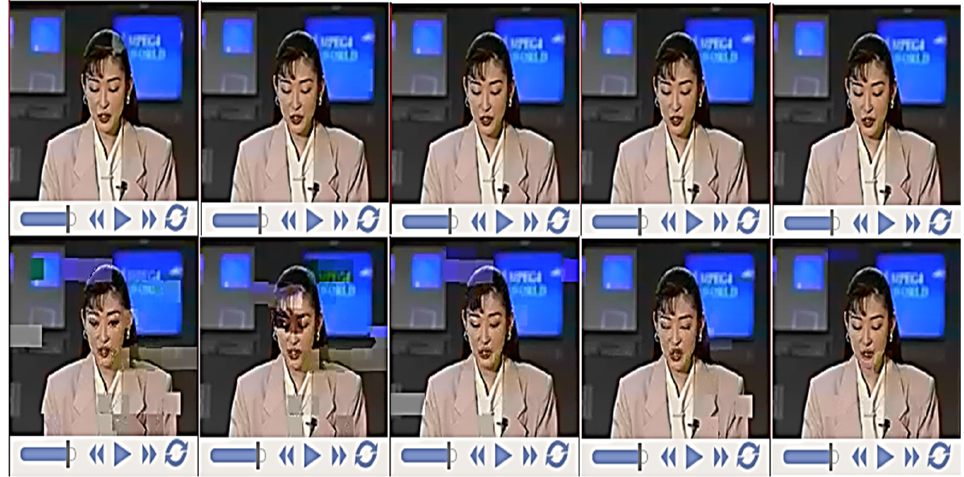
Figure 6. Subjective video quality performance using the ( top ) LSSTC-SP-URC-SBC [ 2,6 ] at ( left to right ) E b / N 0 = 8.5 dB, 9 dB, 9.5 dB, 10 dB and 10.5 dB and ( bottom ) LSSTC-SP-URC-SBC ∗ [ at ( left to right ) E b / N 0 = 28.5 dB, 29 dB, 29.5 dB, 30 dB and 30.5